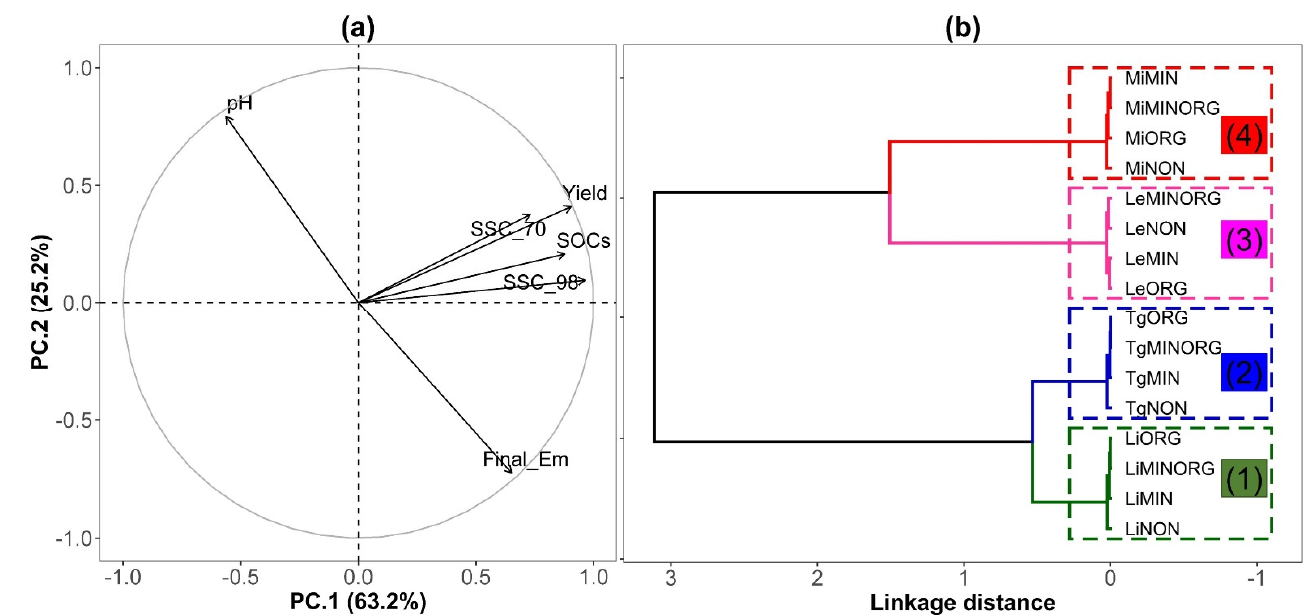
Figure 6. Normalized principal component analysis (PCA) and hierarchical clustering of principal components (HCPC) on soil carbon stocks and pH, measured in May 2016, and water yam growth and yield in Liliyo and Tiéningboué (Côte d’Ivoire), and Midebdo and Léo (Burkina Faso), under various fertilization regimes in 2016: ( a ) correlation circle, ( b ) dendrogram of hierarchical clustering based on the Ward’s criterion. The linkage distance of the branches indicates the dissimilarity between clusters. The fertilization regimes are: NON (no fertilization), MIN (sole mineral fertilization as NPK), MINORG combined organic and mineral fertilization), and ORG (sole organic fertilization as manure). SOCs = Soil carbon stocks; pH = pH (H 2 O); Final_EM = final sprout emergence rate; SSC_70 = Soil surface coverage by water yam above-ground organs at 70 days after planting; Yield = Yam fresh tubers yields in t ha − 1 ; Li = Liliyo; Tg = Tiéningboué; Mi = Midebdo; Le = Léo.